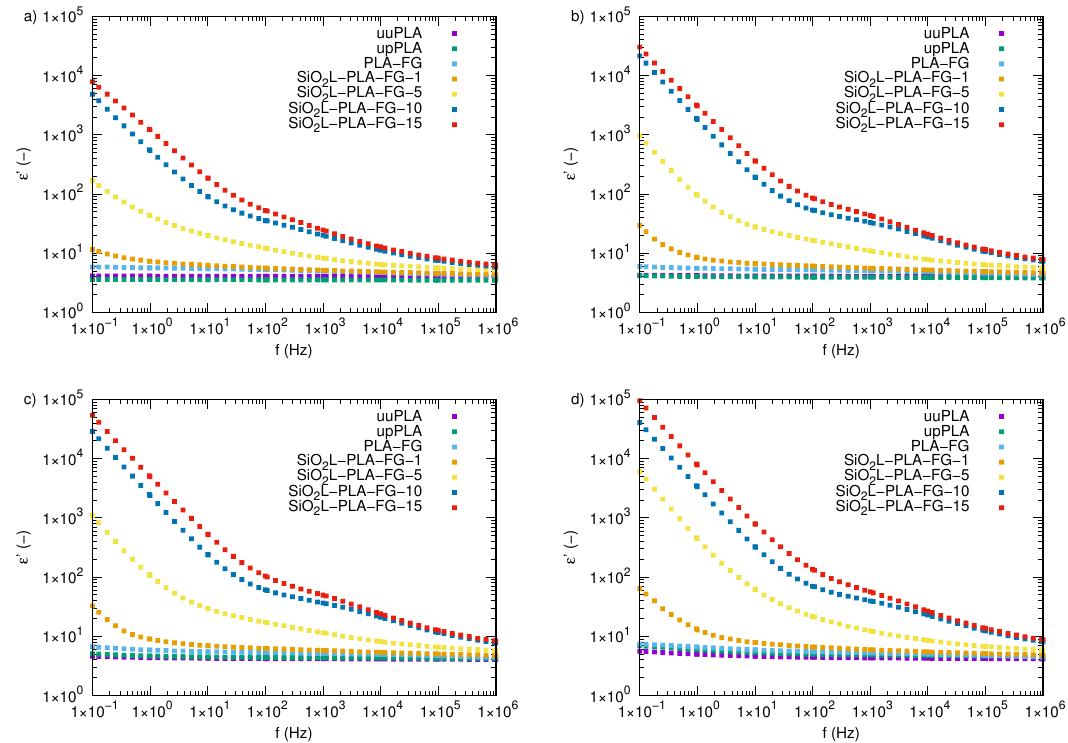
Figure 4. The real part of the complex permittivity of silicon-dioxide–lignin nanocomposites as a function of frequency for ( a ) 293.15 K, ( b ) 323.15 K, ( c ) 328.15 K, and ( d ) 333.15